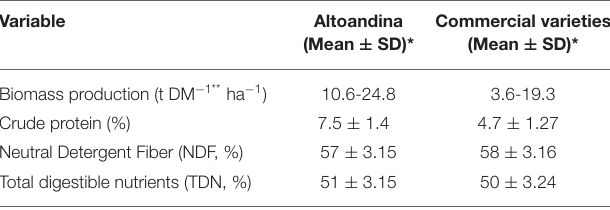
TABLE 1 | Forage production and nutritional quality of Altoandina and commercial oat varieties. Variable